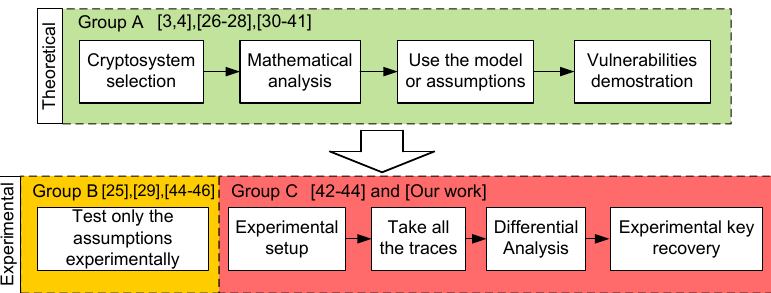
Figure 1. General classification of different type of cryptanalysis